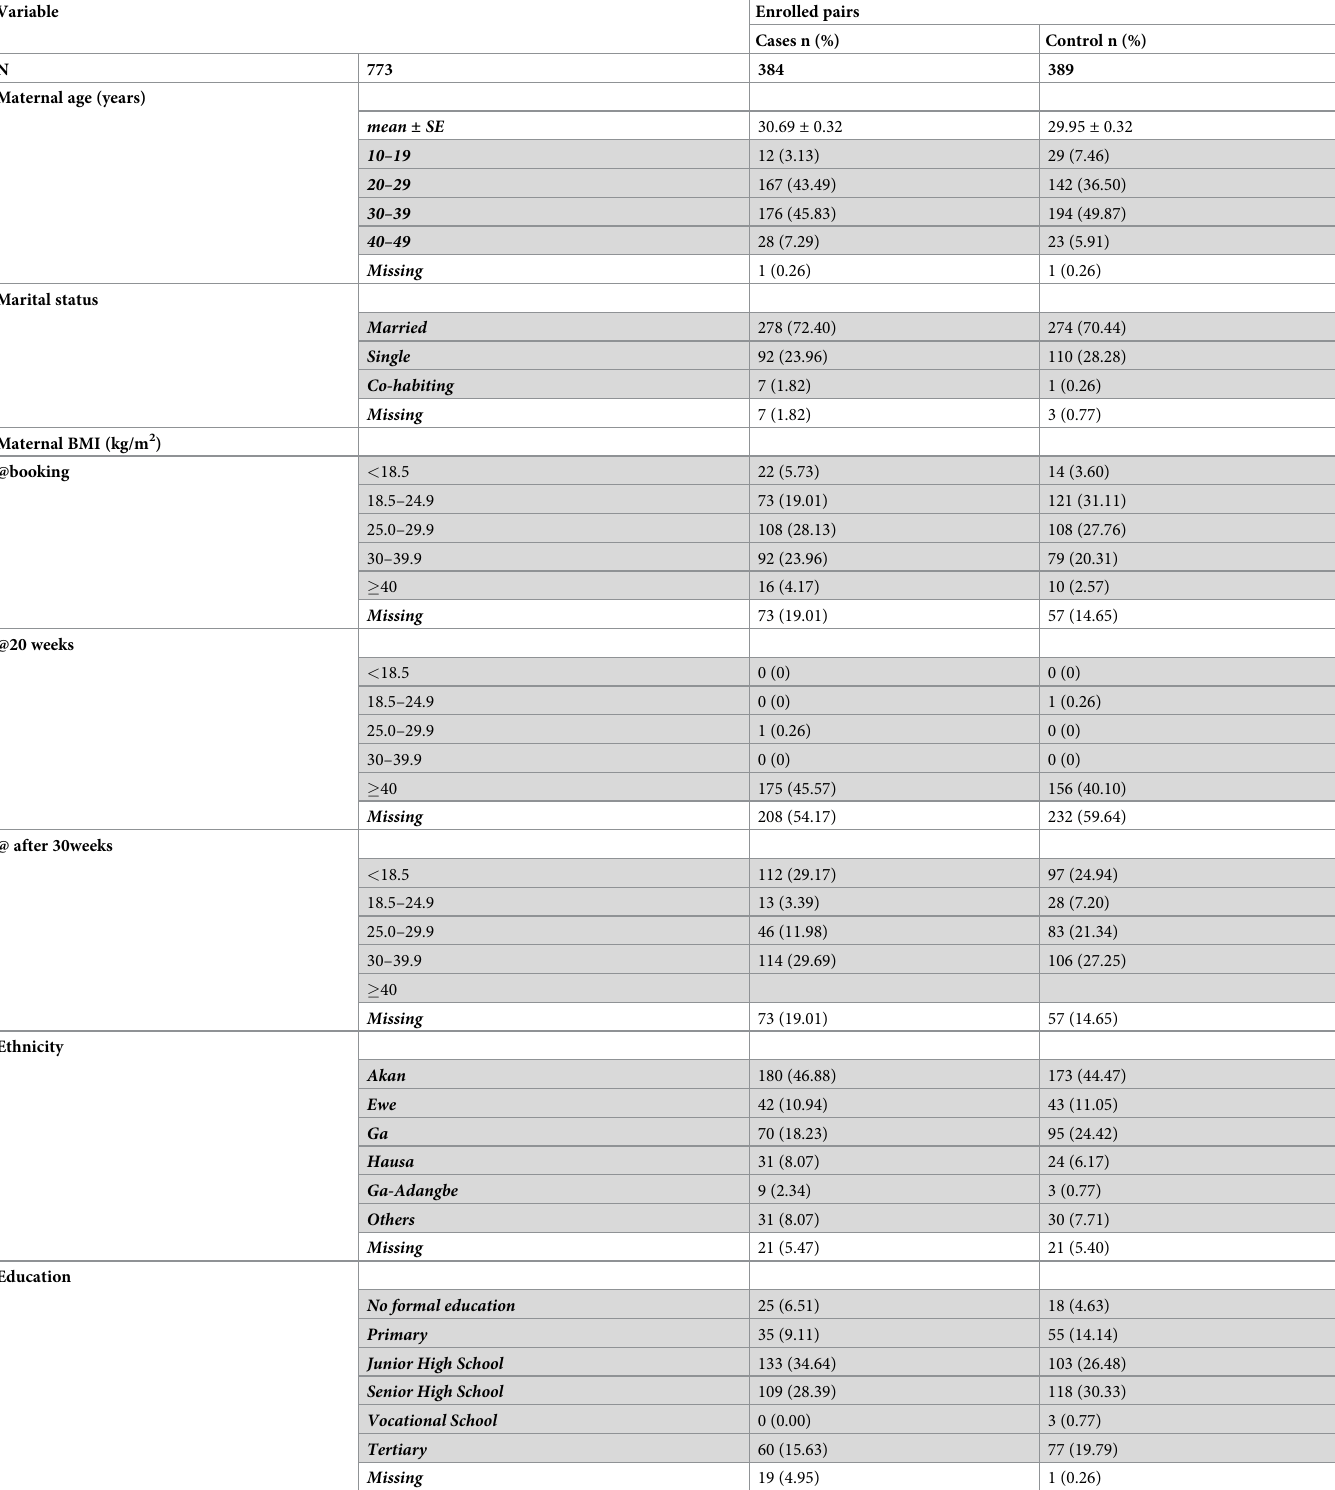
Table 3. Characteristic of recruited patients with and without